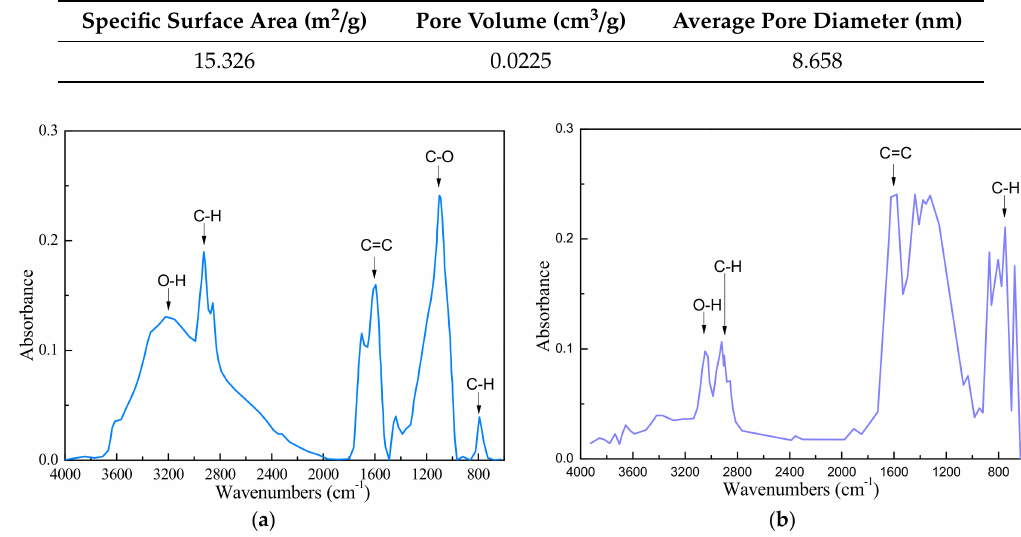
Table 4. Characteristics of the pore structure of LRC sample.